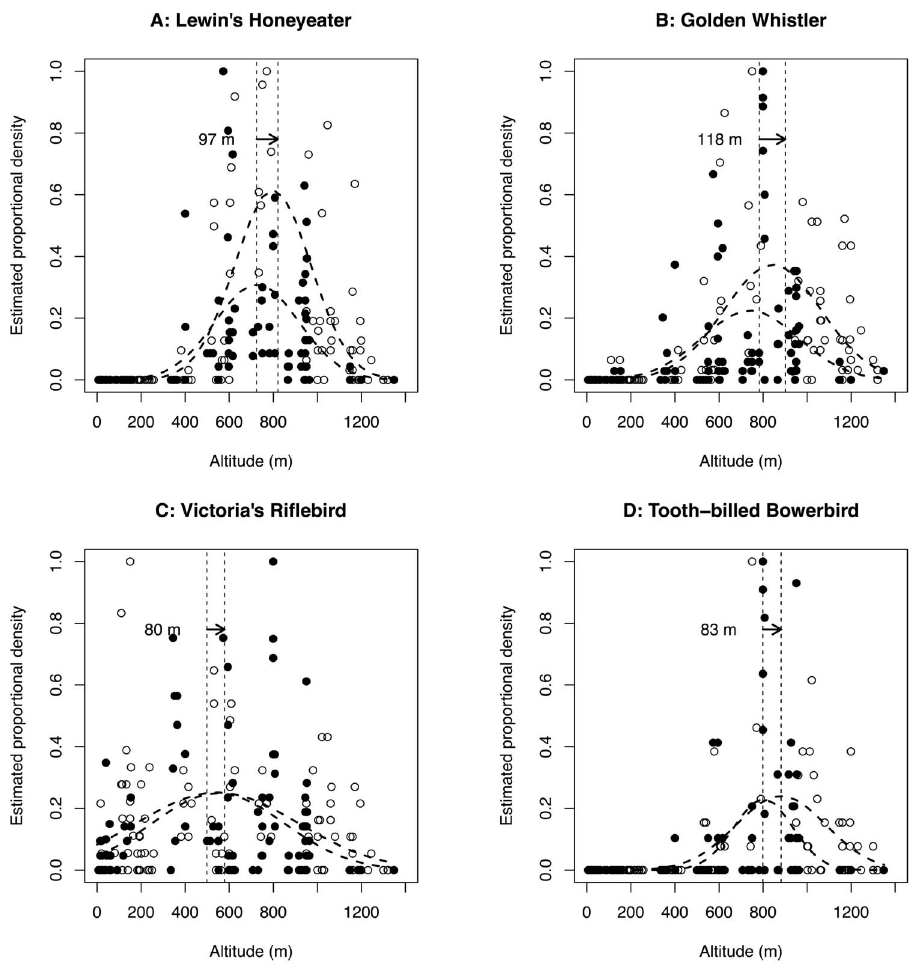
Figure 3. Elevational density profiles. Shown are example plots for 4 of the 10 species exhibiting a significant difference between the elevation of density optima between southern (filled circles) and northern (unfilled circles) AWT populations according to 84% Confidence Intervals (see text for explanation of this choice). Data are proportional estimated densities corrected for detectability at each sampling point. The vertical lines mark the estimated elevations of density optima in the two regions. Arrows and their labels indicate the direction and magnitude of the estimated elevational shift in each case. See table 2 for species’ scientific names.